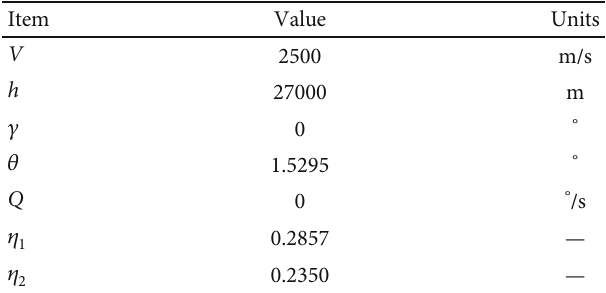
Table 1: HFV state initial